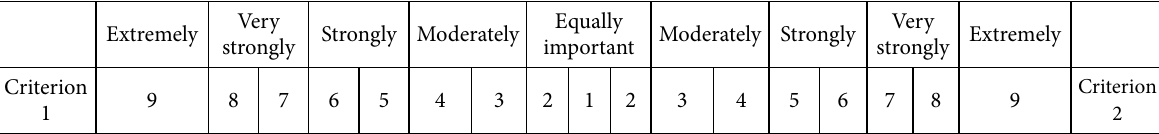
Table 5. Criteria weighting ( w